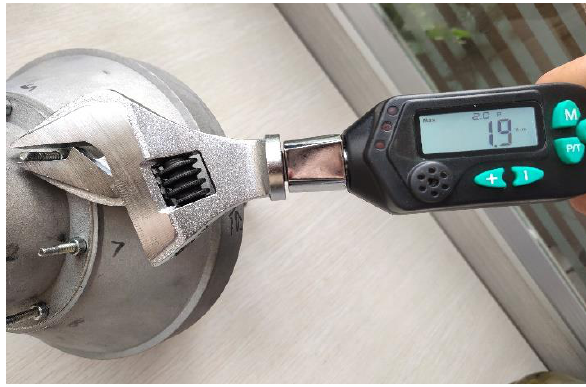
Figure 11. Digital display electronic torque wrench.